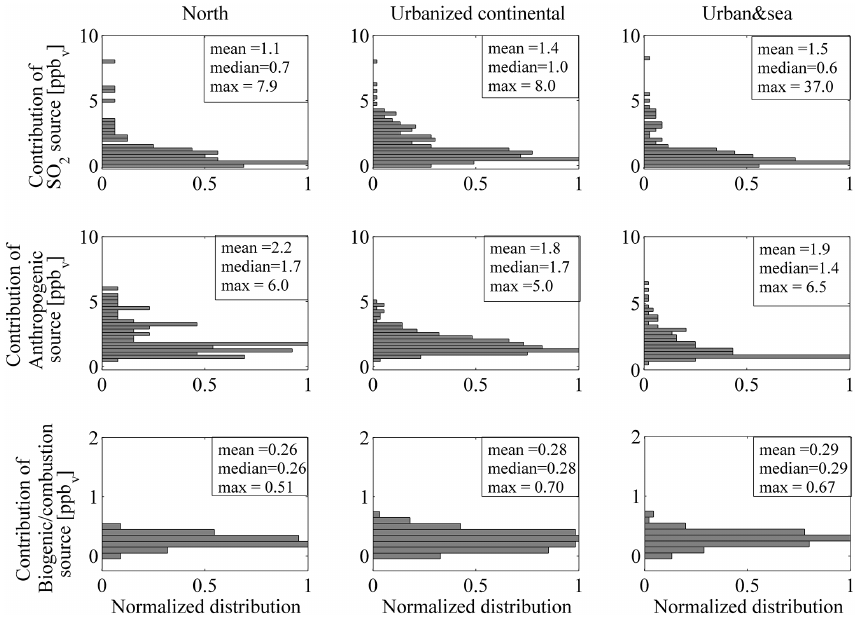
Figure 11. Normalized distributions of different sources in three sectors during the winters. The first column is the north sector ( N = 142), the second column is the urbanized continental sector ( N = 714) and the third column is the urban and sea sector ( N = 391). In the topmost row all panels are distributions of the SO 2 source, the middle row the anthropogenic source and the lowest row the biogenic/combustion source. Each sector has been normalized with the maximum value of the observations. Mean, median, and maximum values of source contributions are shown for each